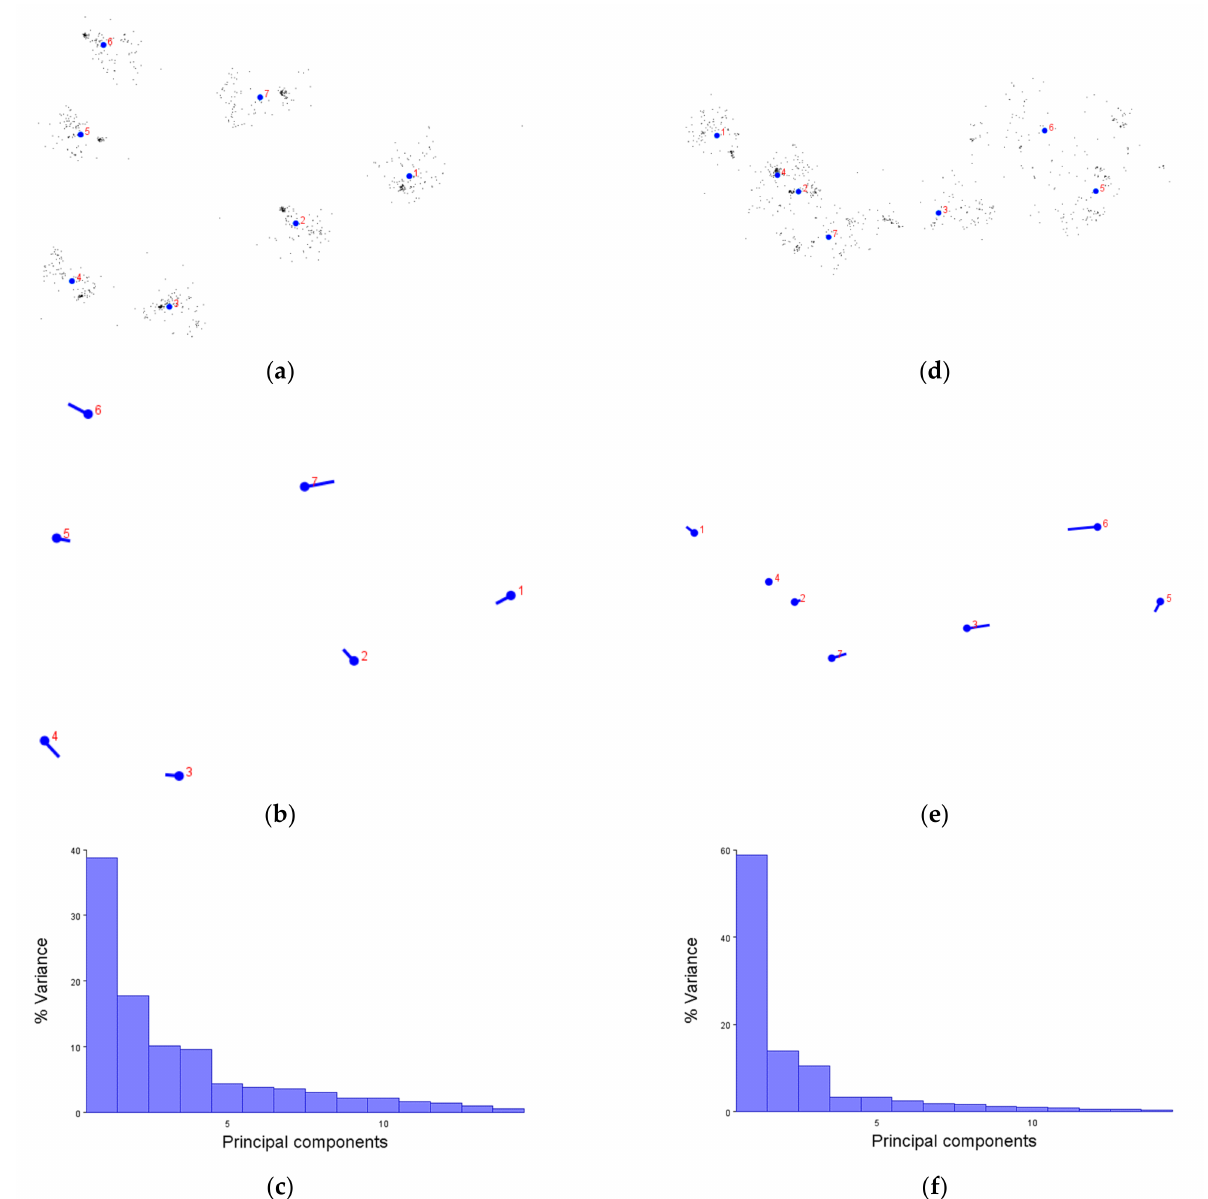
Figure A4. Supplementary graphs to support Figure 6. ( a ) Generalised Procrustese transformation, ( b ) PC1 variation and ( c ) eigenvalues for the extracellular face of the A2AR, β 1AR and β 2AR receptors. ( d ) Generalised Procrustese transformation, ( e ) PC1 variation and ( f ) eigenvalues for the intracellular face of the A2AR, β 1AR and β 2AR